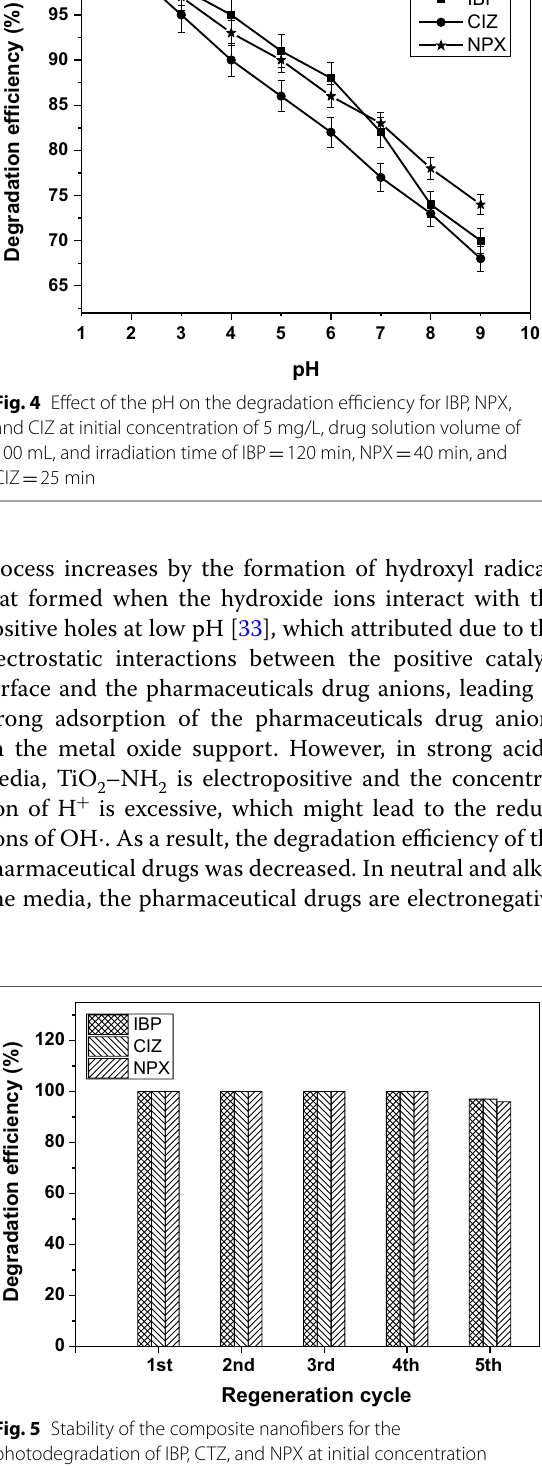
120 min, NPX 40 min, and = =